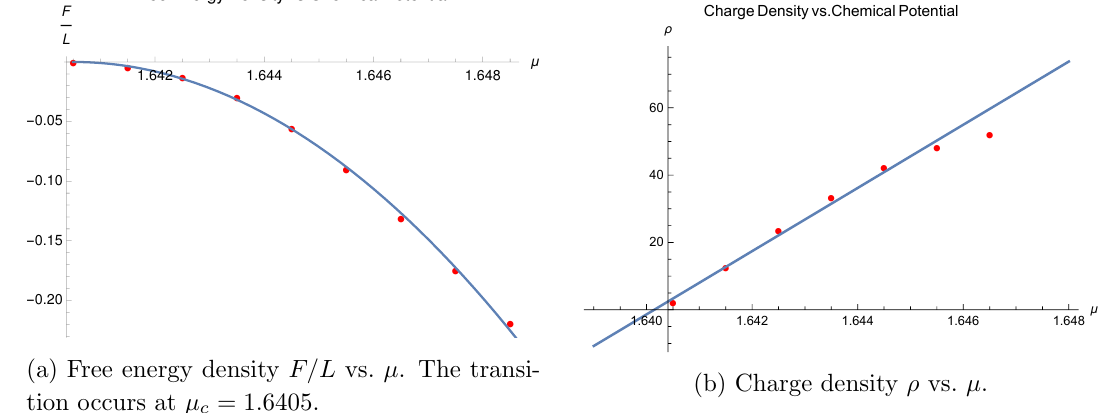
(b) Charge density (cid:26) vs. (cid:22) .